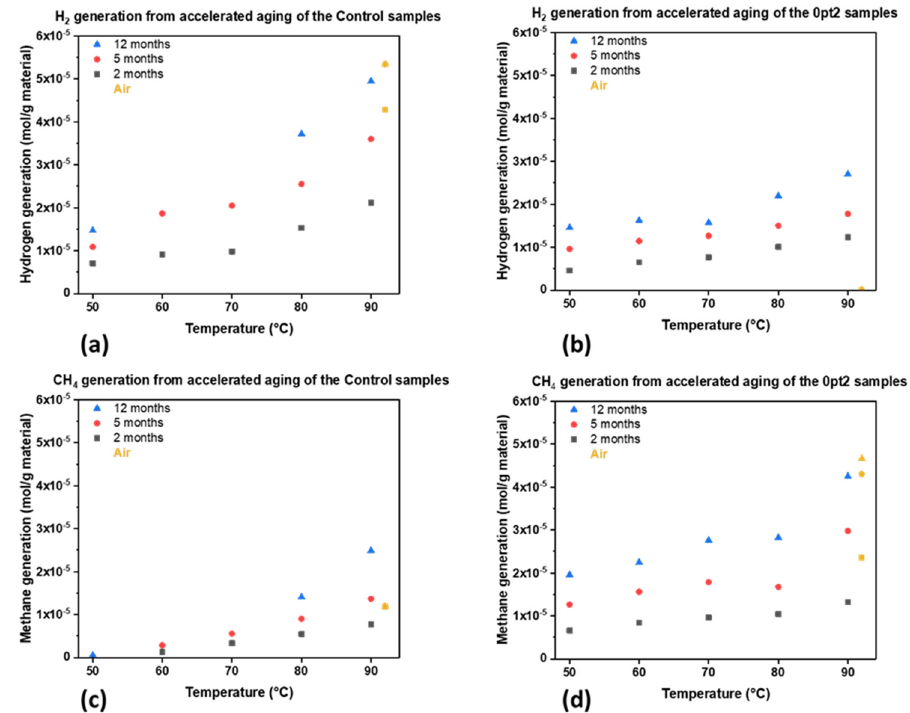
Figure 6. Measuring the volatile products that evolved while undergoing thermal accelerated aging on a per-mass-of-Sylgard basis: ( a ) hydrogen generation from the Control; ( b ) hydrogen generation from 0pt2; ( c ) methane generation from the Control; and ( d ) methane generation from 0pt2. It is possible to draw conclusions about the specific crosslink density using Equation